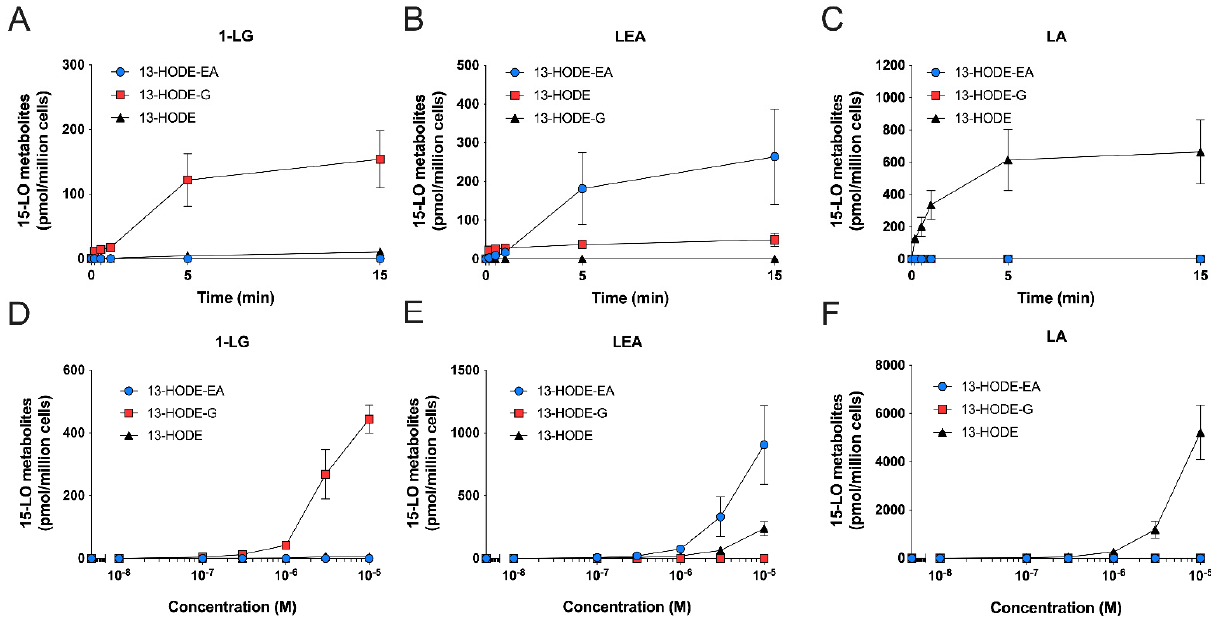
Figure 5. Time- and concentration-dependent synthesis of 15-LO metabolites from 1-LG, LEA, and LA by human eosinophils. Pre-warmed human eosinophils suspensions (10 6 cells/mL in HBSS containing 1.6 mM CaCl 2 ) were treated with 3 µM of ( A ) 1-LG, ( B ) LEA, or ( C ) LA for the indicated times. ( D – F ) Eosinophils were treated with increasing concentration of ( D ) 1-LG, ( E ) LEA or ( F ) LA for 5 min. In experiments involving 1-LG, cells were pretreated with MAFP for 5 min prior to the addition of 1-LG. Incubations were stopped by adding one volume of cold ( − 20 ° C) MeOH containing the internal standards. Samples then were processed for LC-MS/MS analyses as described in methods. Data are the mean (±SEM) of 4–5 independent experiments.